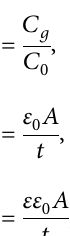
Figure 1: M ′ versus frequency for (a) 0.85PMN-0.15KBT, (b) 0.75PMN-0.25KBT, and (c) 0.65PMN-0.35KBT compositions at different